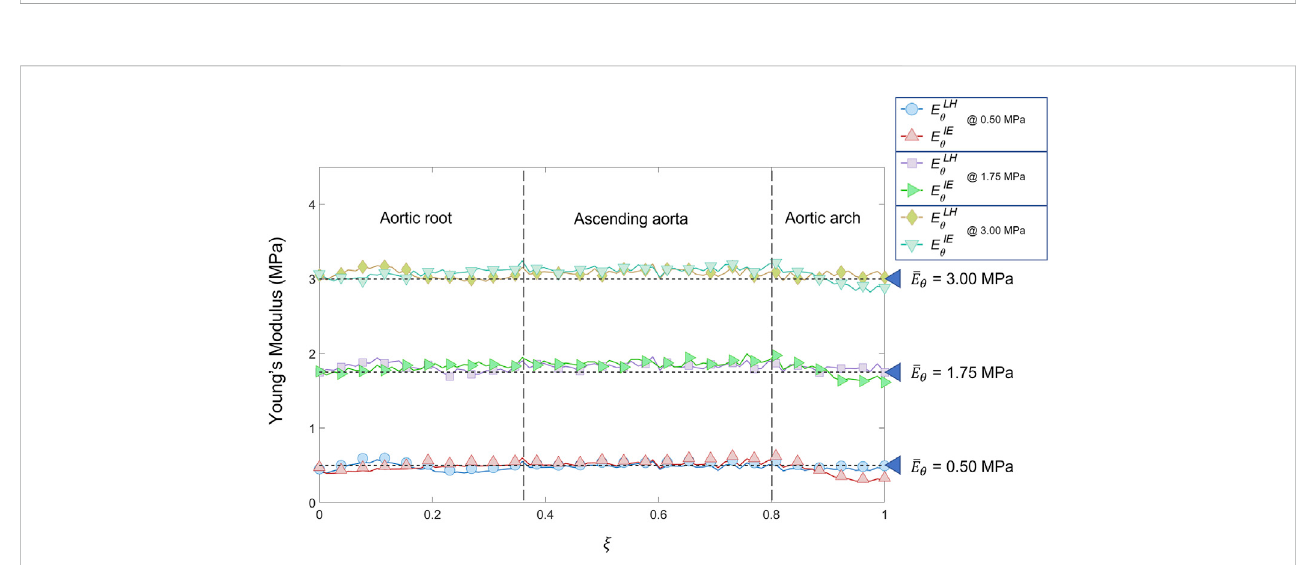
FIGURE 9 Young ’ s modulus variation along the centerline coordinate according to both LH and IE methods for the patient-speci fi c homogeneous distributions cases ( (cid:1) E H θ (cid:2) 0.5 MPa, 1.75 MPa, 3.0 MPa) compared with the reference